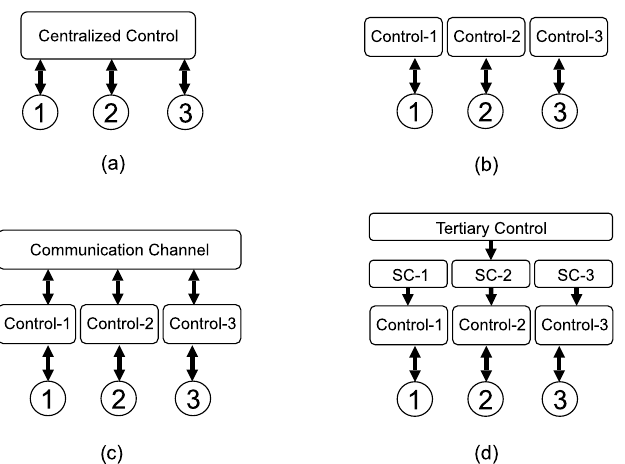
Figure 33. Concept of centralized and decentralized control: ( a ) Centralized control. ( b ) Decentralized individual control. ( c ) Distributed control with communication channel. ( d ) Multiple control levels as orimary, secondary control (sc), and tertiary